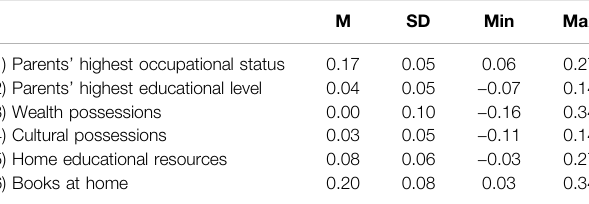
TABLE 2 | Descriptive statistics of the standardized coef fi cients of different SES components, averaged across three academic domains, in 77 societies. M SD Min Max